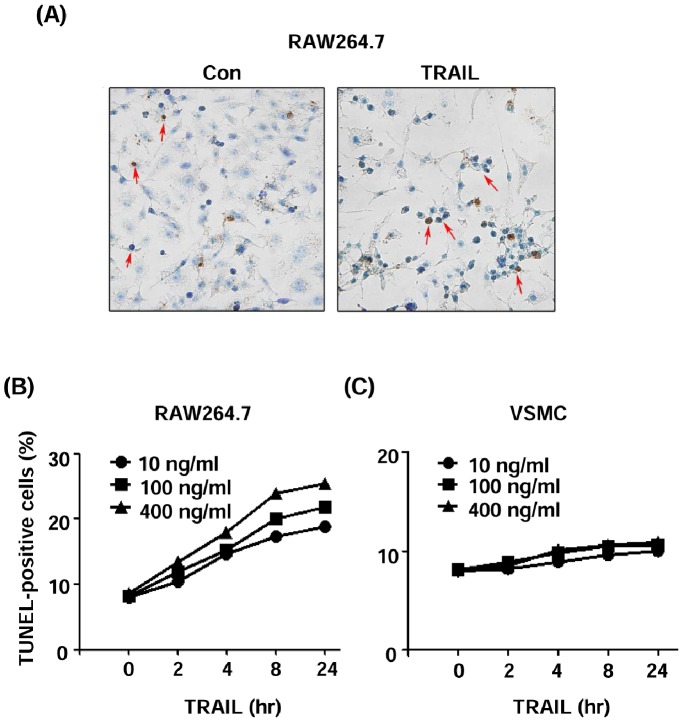
Effects of TRAIL on apoptosis of macrophage and vascular smooth muscle cells (VSMCs).(A) Representative images of TUNEL labeling showing apoptotic cells (arrows) in control and TRAIL-treated (100 ng ml−1 for 24 hr) RAW264.7 cells. (B) Quantitative analysis of TUNEL-positive RAW264.7 cells after treatment with TRAIL (10, 100 and 400 ng ml−1) for various time as indicated. (C) Quantitative analysis of TUNEL-positive cells in VSMCs after treatment with TRAIL for different time. Data are % of total cells averaged from triplicate experiments.